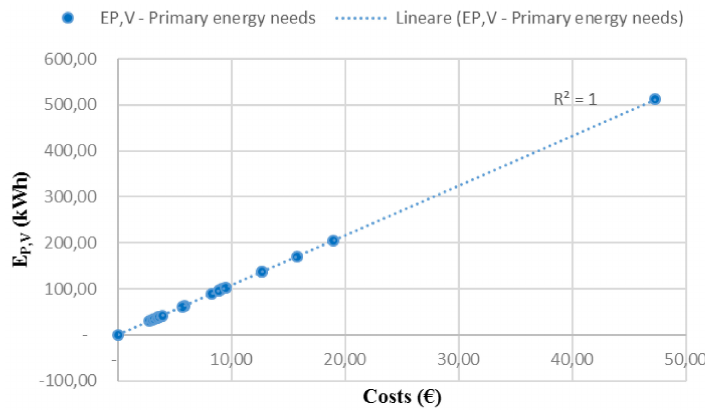
Figure 7. Relationship between E P,V and management costs. NB: all the figures use dots and commas as per Italian